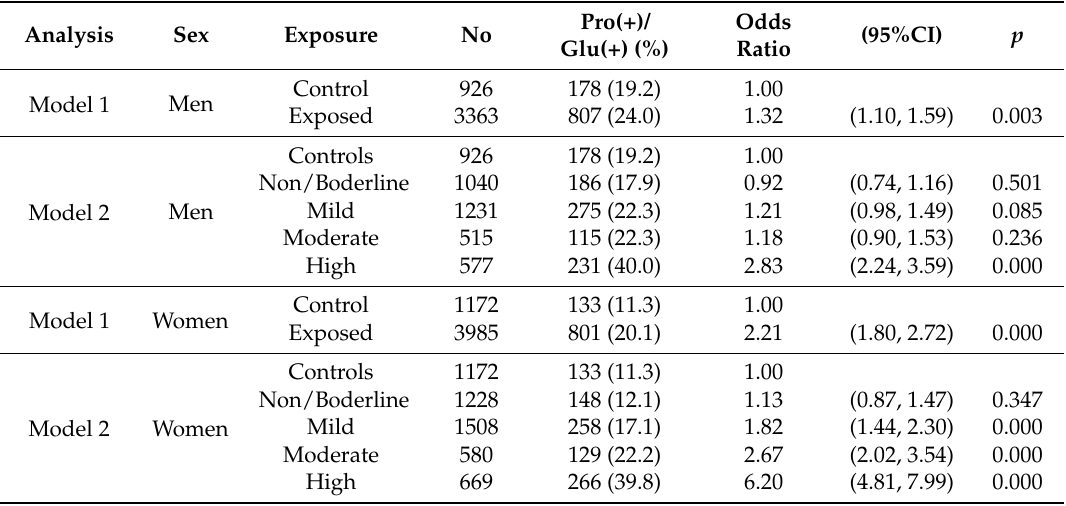
Table 3. Prevalence of renal damage indicated by proteinuria, glucosuria, and glucoproteinuria and Cd